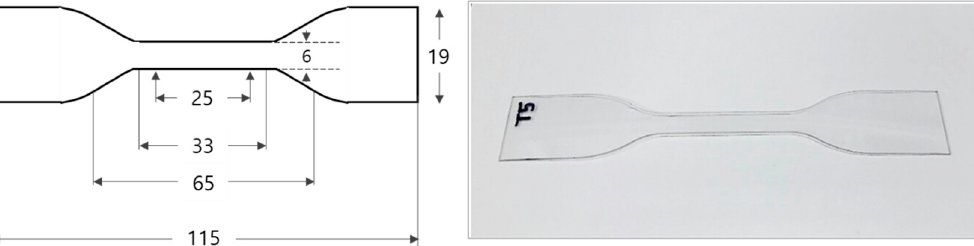
Figure 3. Dimensions and actual appearance of tensile-strength specimen.